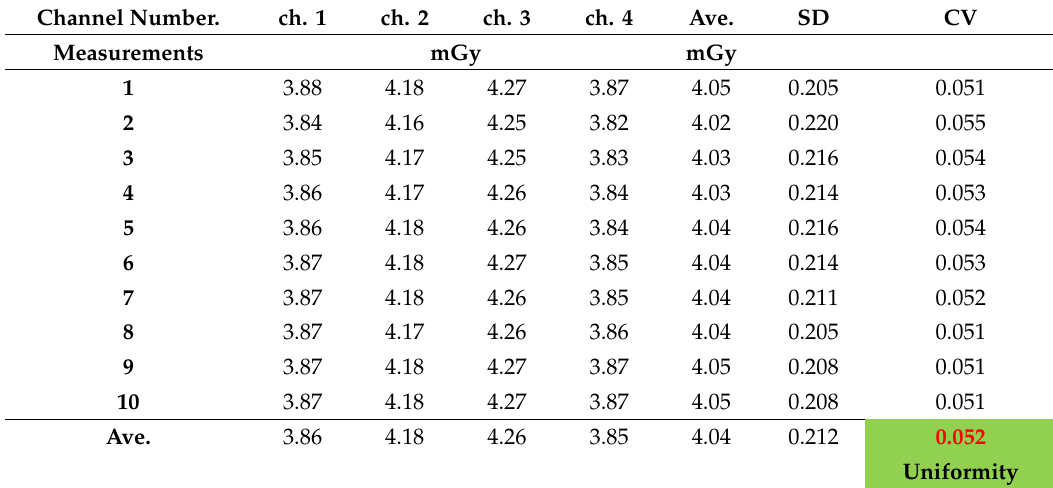
Table 1. Uniformity of the 4-channel novel sensors. Channel Number.